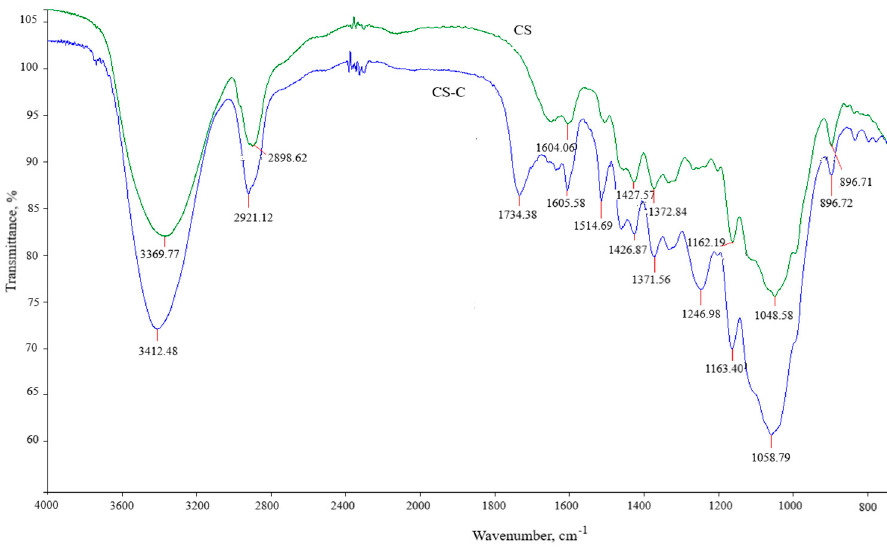
Figure 1. FT-IR spectra for unmodified (CS) and citric acid-modified (CS-C) corn